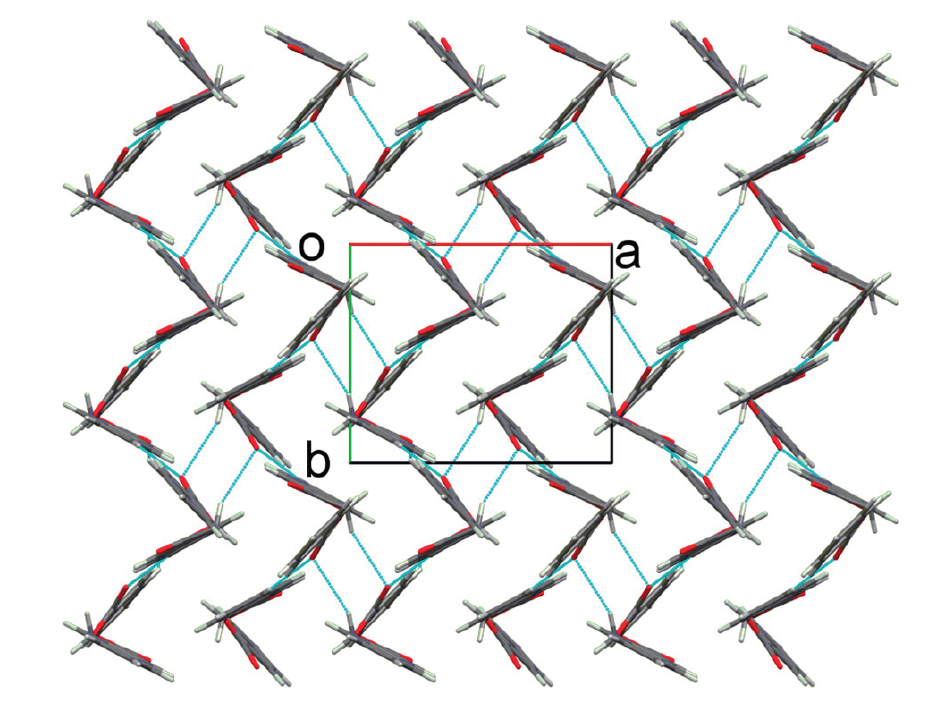
Figure 5. Three-dimensional assembly in 4a with hydrogen bonds (blue dotted